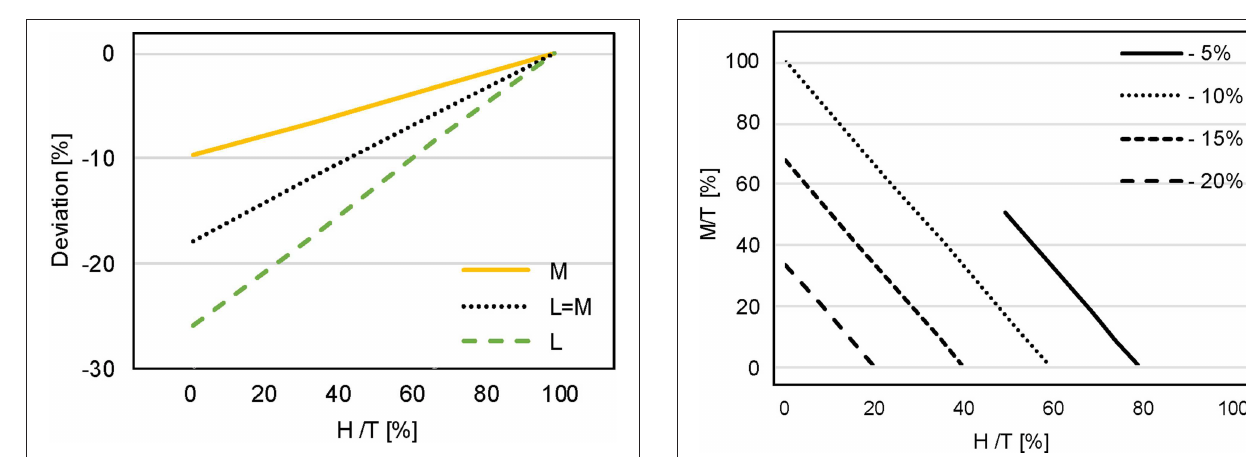
FIGURE 1 | Deviation of the annual heating demand from the benchmark, depending on the fraction of H, M, and L in total population. Reproduced from Mahdavi et al. (2018) with permission from A. Mahdavi, M. Taheri, and F. Tahmasebi.